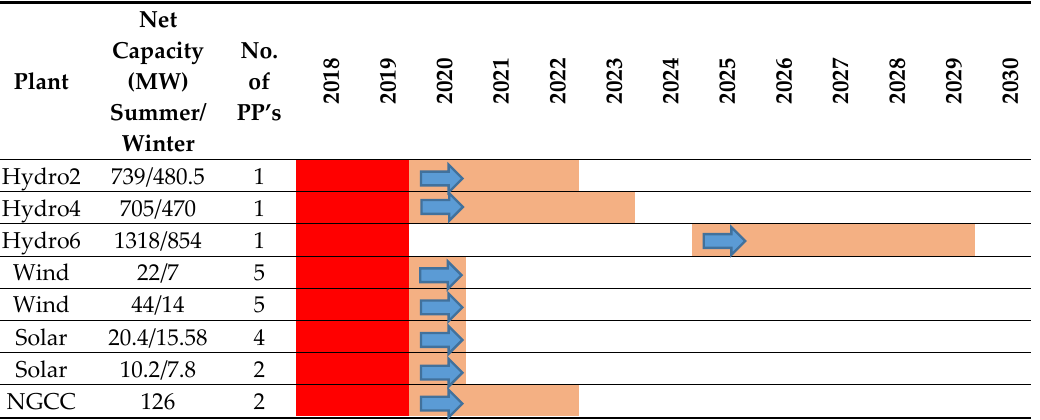
Table A2. Details of the Plants Installation under Capacity Expansion: Low GDP Fuel Balancing (2–20% Mitigation).